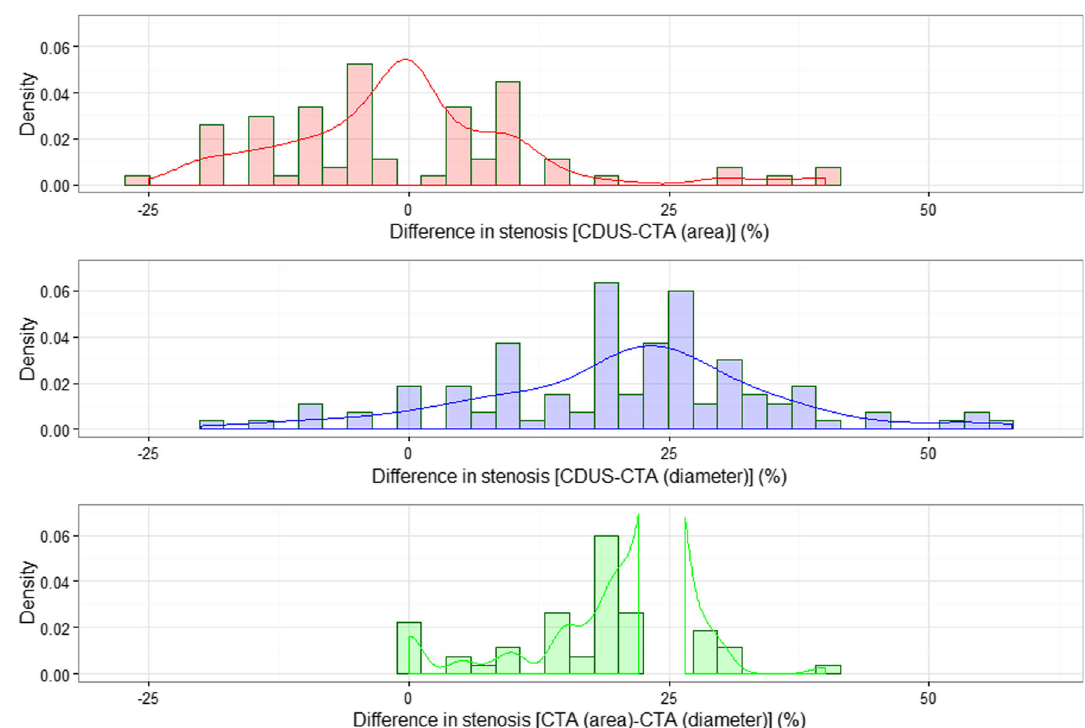
Fig. 2 Empirical distributions of differences in stenosis measurements from three pairs of methods